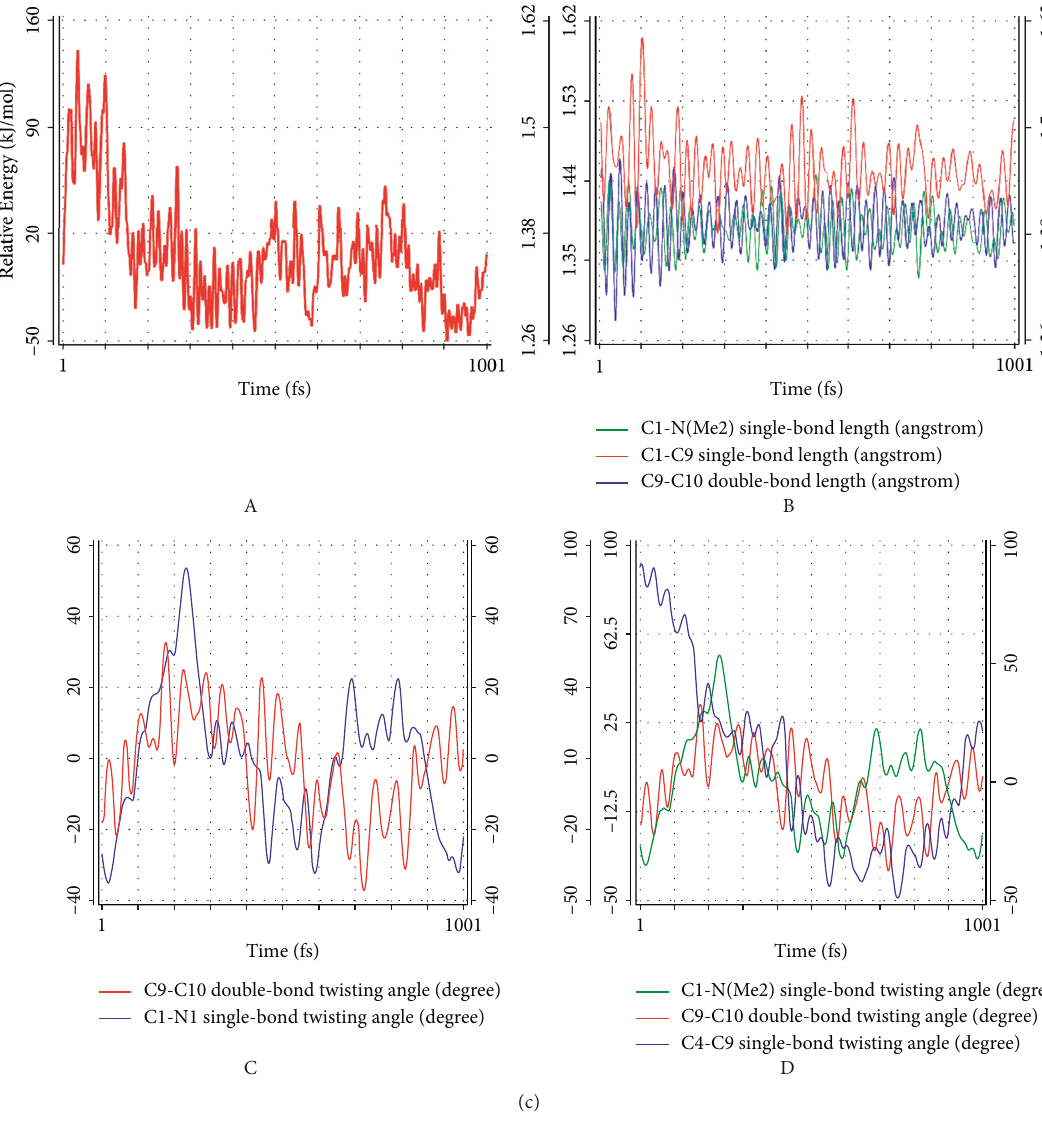
Figure 13: Time evolution of (a) the relative potential energy and bond lengths of the C9-C10, C4-C9, and C1-N1 bonds. (a) the trajectory starts from 90 ° twisting angle for S1-bond while (b) the trajectory start from (d) the intersection point of the seam at 176 ° twisting angle for D-bond. (b) Bond twisting (dihedral angles) and pyramidalization of C10 ((a) at 90 ° twisting angle for S1-bond and (b) at 176 ° twisting angle for D-bond). (c) Changes in properties during 1000femtoseconds